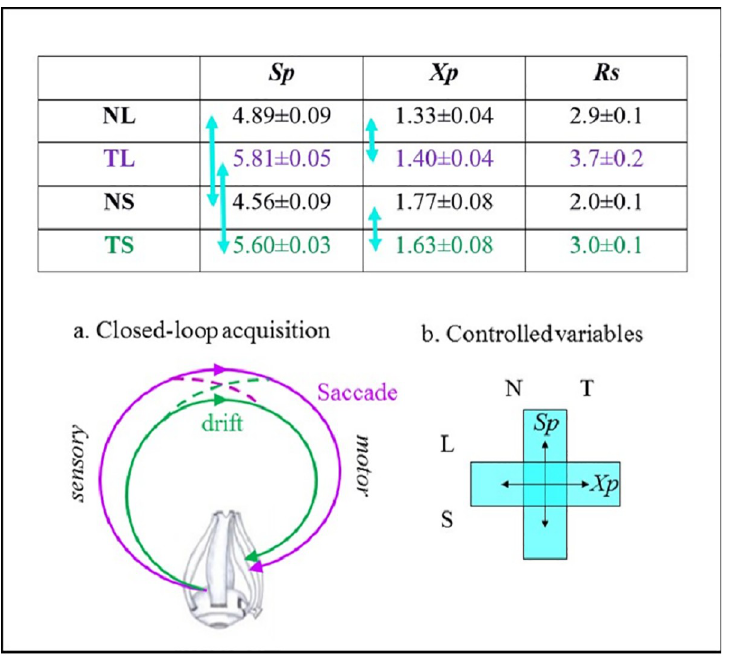
Fig 5. Control variables and closed-loop visual acquisition. ( upper table ) Mean ± SEM of visual scanning variables during each viewing condition (NL, natural large; TL, tunneled large; NS, natural small; TS, tunneled small). Sp is the mean instantaneous drift speed during a pause in deg/s, Xp is the distance travelled during a pause ( drift length) in deg and Rs is the mean saccadic rate per trial. Light blue arrows indicate values that do not differ statistically (p > 0.15); all other differences were statistically significant (p < 0.05). ( a ) Coordinated saccade and drift closed-loops. The two loops interact with each other, coordinating the control of the acquisition. ( b ) Controlled variables. The scheme symbolizes the maintenance of Sp across image size (large and small) and the maintenance of Xp across viewing conditions (natural and tunneled).